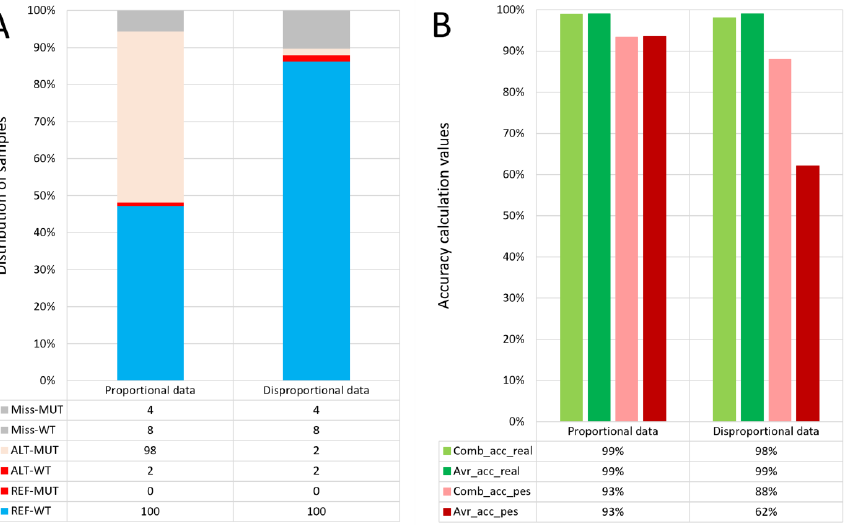
Figure 1. A comparison of proportional and disproportional data based on the accuracies. The figure shows a comparison of two types of datasets with proportional and disproportional data by phenotype. The disproportional data simulates the cases with only a small number of samples with mutant phenotypes available. Plot ( A ) shows the sample distribution transformed into percentages from sample counts. The counts are available in the table below plot ( A ). They represent the number of samples in groups defined by a phenotype and genotype pair. Plot ( B ) shows the difference in four types of accuracy calculations (values available in the table below the plot) according to the dataset type. The accuracy calculations are counted from sample counts shown in plot ( A